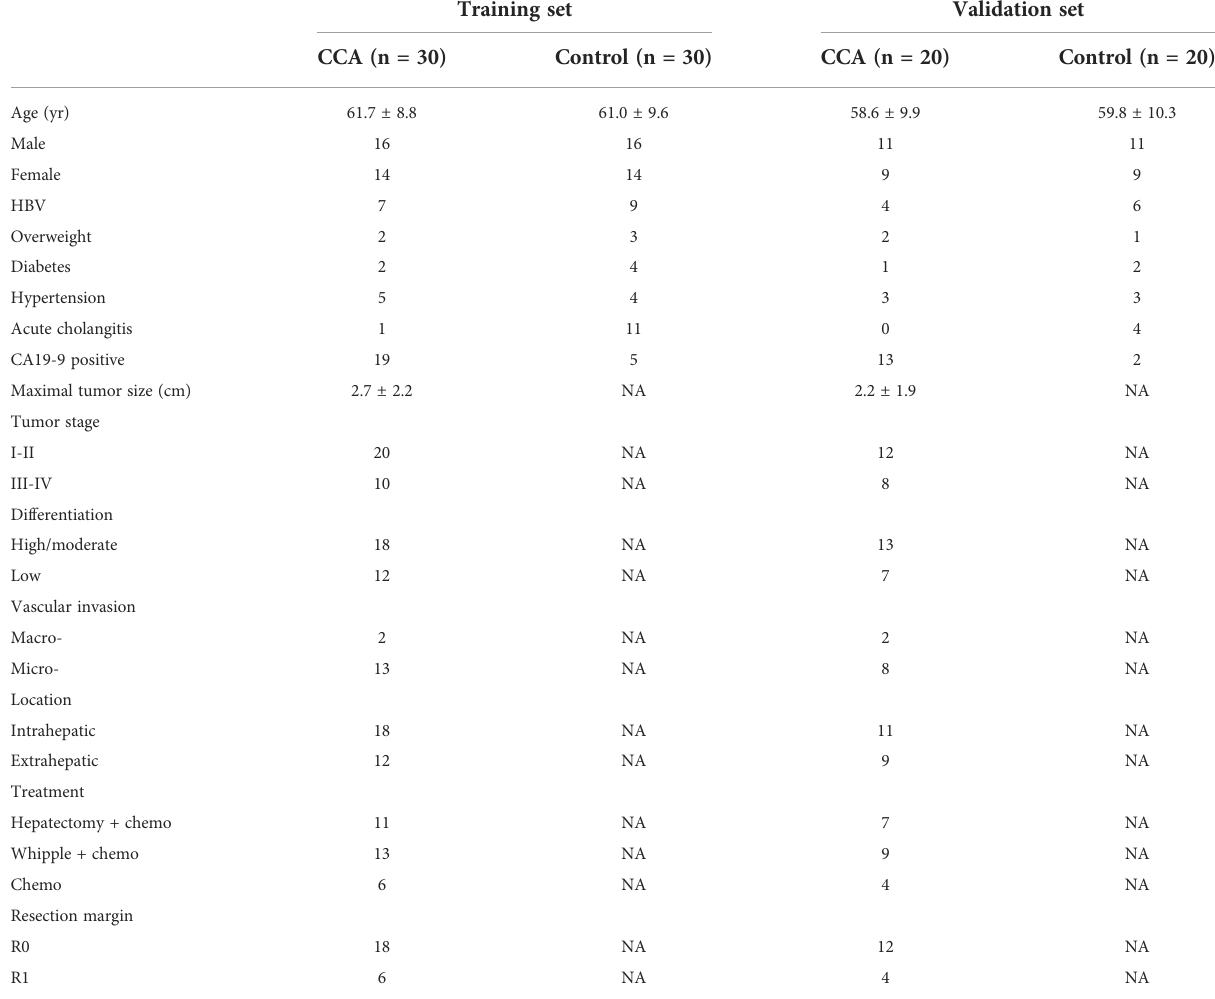
TABLE 1 Patient